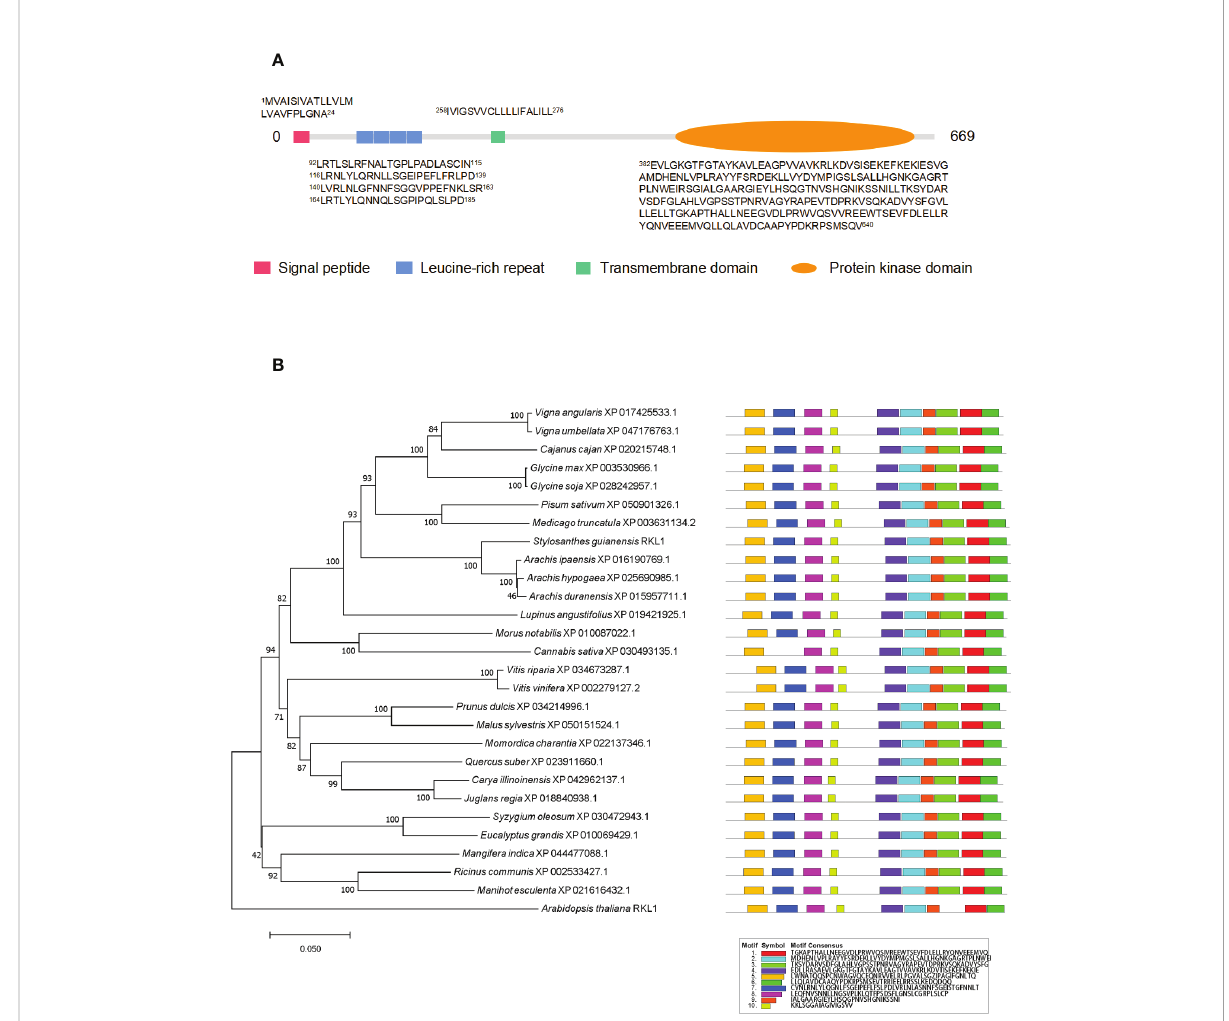
FIGURE 7 The domain, phylogenetic and motif analysis of SgRKL1. (A) The domain analysis of SgRKL1. The red box represents the signal peptide, blue box represents Leucine-rich repeat, green box represents the transmembrane domain, and the orange oval represents the protein kinase domain. The sequences of amino acid of each domain were listed correspondingly. (B) Phylogenetic tree and motif analysis of RKL1 protein sequences from 28 plant species. The legend represents the sequence of amino acids in the corresponding